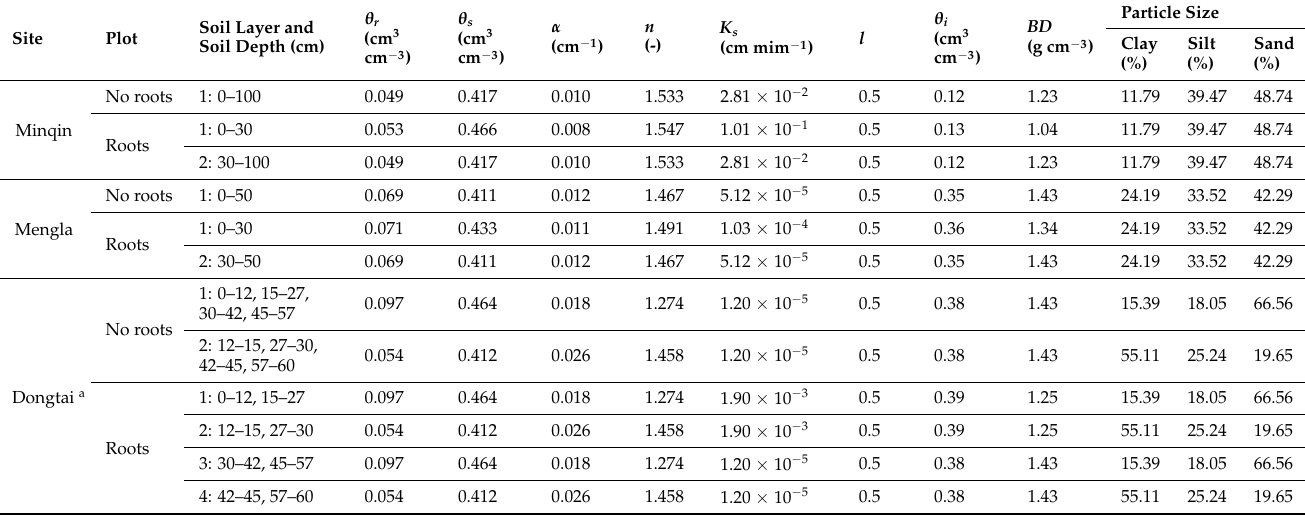
Table 3. Soil hydraulic parameters for the van Genuchten–Mualem model